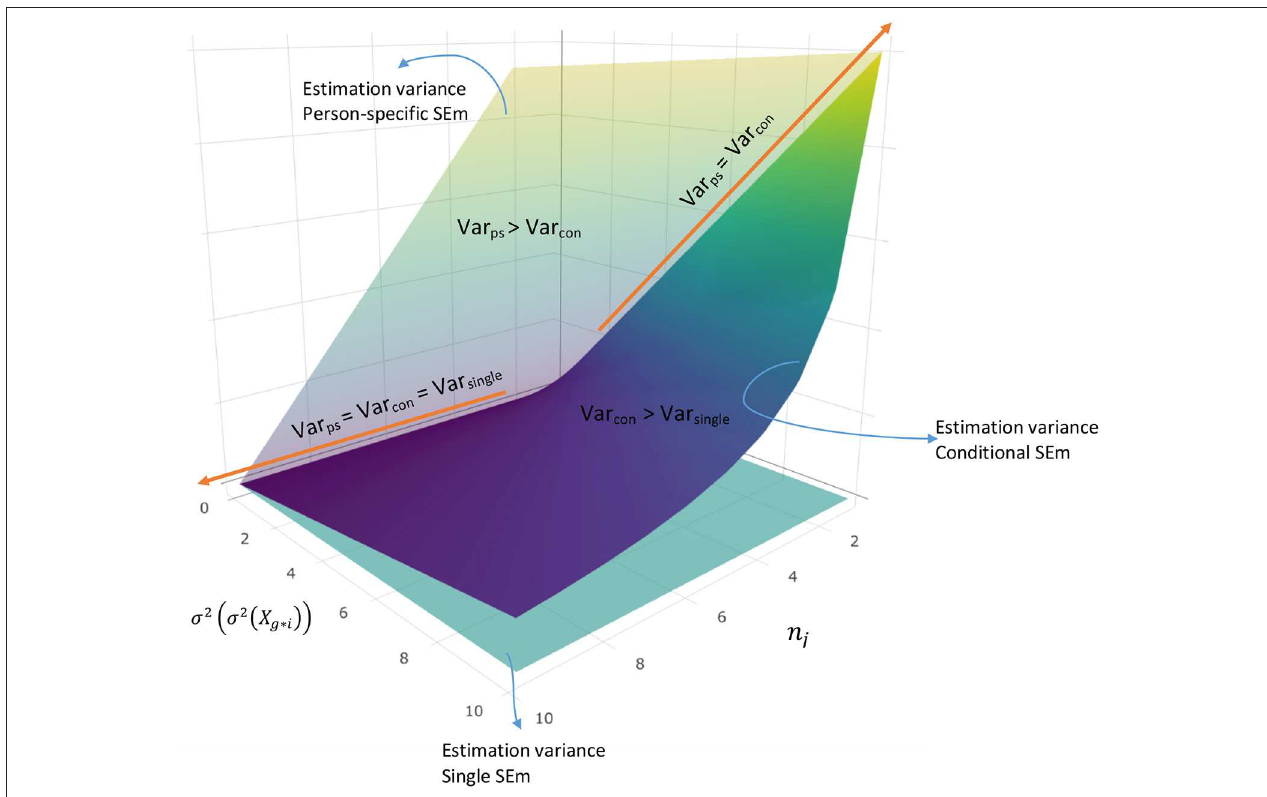
FIGURE 2 | Relationship between the estimation variance of the person-specific -, conditional,- and single error variance, for a fictional examinee i